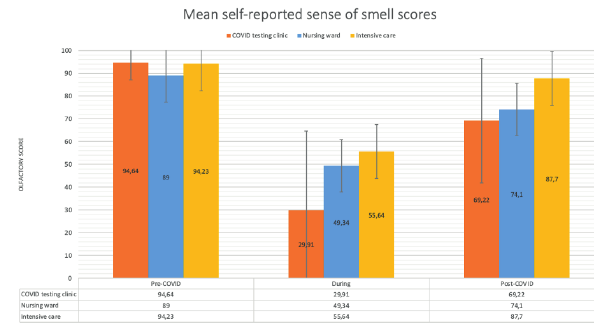
Figure 4. Smell and taste self-reported scores of CTC, nursing ward and ICU.